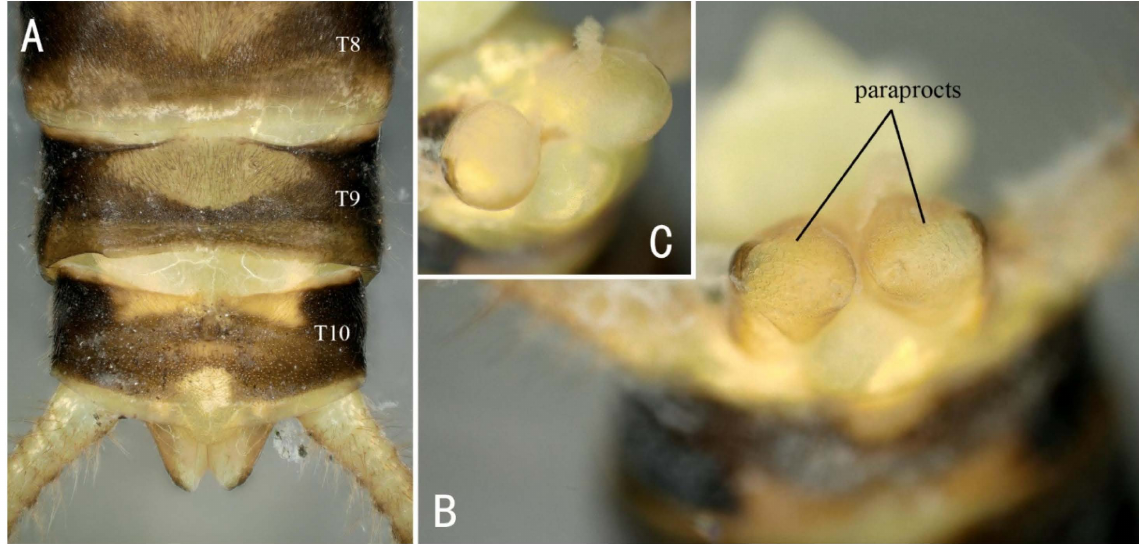
Figure 9. Filchneria zhouchangfai from Anhui, male. ( A ) terminalia, dorsal; ( B ) paraprocts; ( C ) para‑ procts fully everted with liquid. T is for “tergum” (plural: